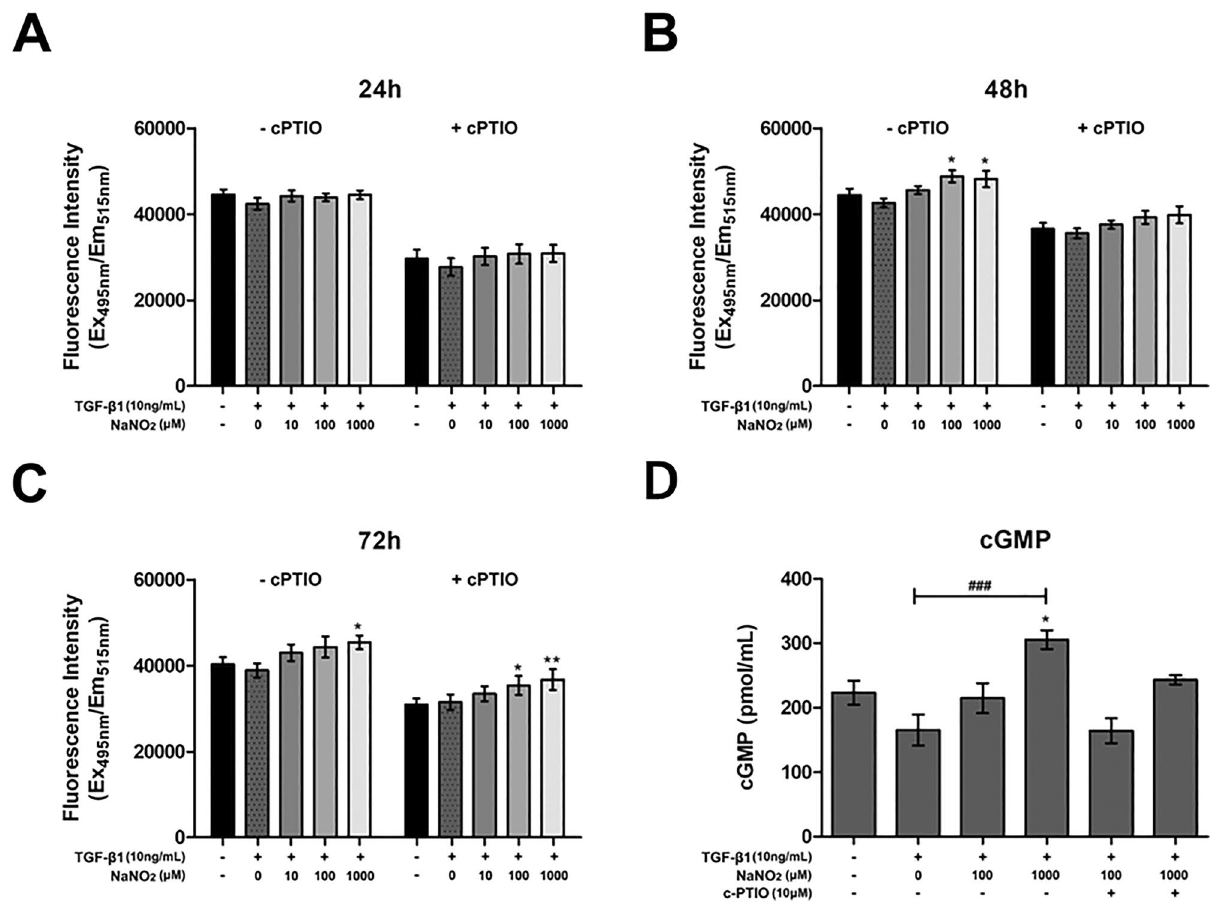
Figure 2. The effect of sodium nitrite on the intracellular NO and cyclic guanine monophosphate (cGMP) concentrations. ( A – C ) Sodium nitrite in the culture medium resulted in mild increase of intracellular NO concentration after 24 ( A ), 48 ( B ) and 72 h ( C ) incubation. Addition of 2-4-carboxyphenyl-4,4,5,5- tetramethylimidazoline-1-oxyl-3-oxide (cPTIO, 10 μM) in the culture medium scavenged NO and decreased intracellular NO concentration. ( D ) cGMP increased with the addition of sodium nitrite and addition of cPTIO blunted cGMP generation. *p < 0.05, **p < 0.01, ### p < ROS production in keratocyte stimulated with TGFβ1.